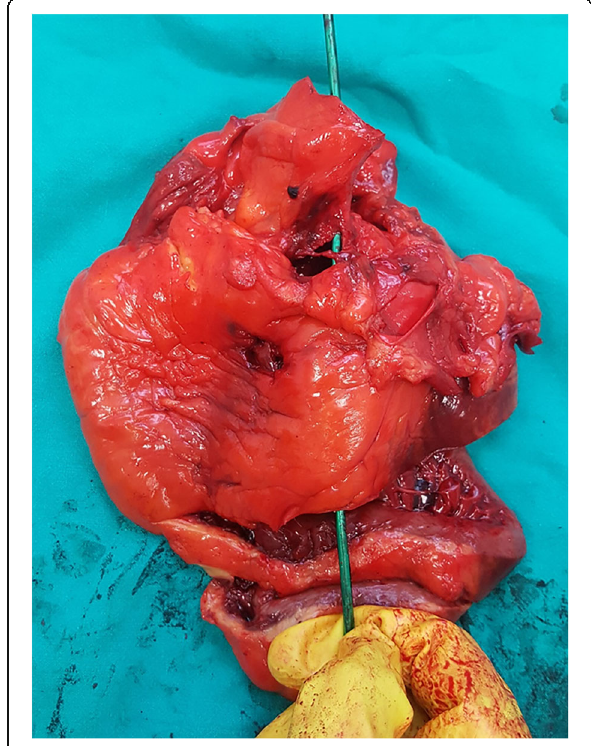
Fig. 1 Heart of the victim. The probe indicates the bullet trajectory